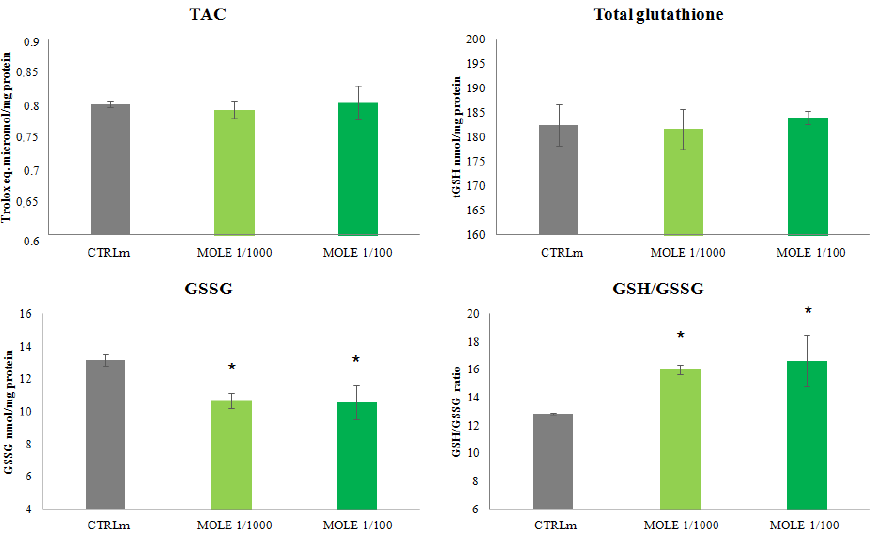
Figure 3. Total antioxidant capacity (TAC) and glutathione homeostasis analysis. Measurement of total antioxidant capacity (TAC), total glutathione (tGSH), oxidized glutathione (GSSG) and reduced to oxidized glutathione ratio (GSH/GSSG) was performed in C2C12 myotubes after 24 h MOLE (1/1000 and 1/100 working solutions) treatments. Data presented are the mean ± SD of three experiments. * p < 0.05 vs. CTRLm.